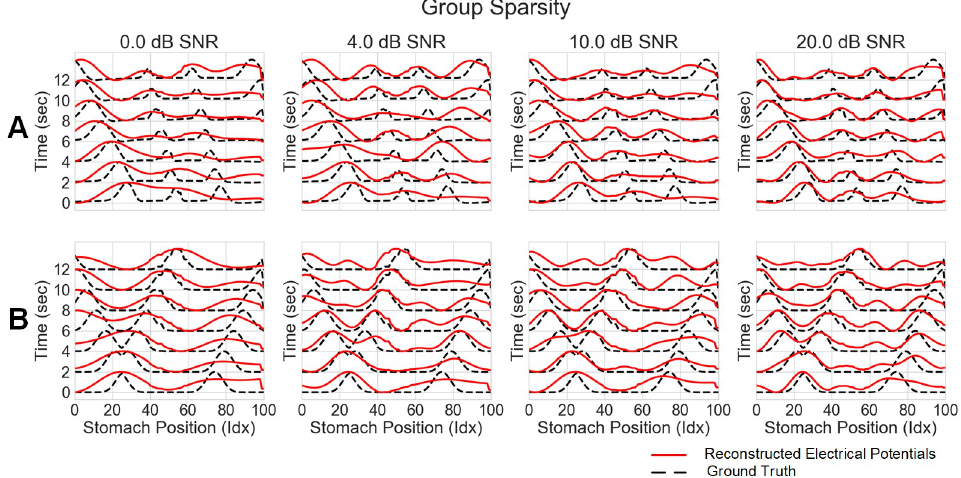
Fig 5. Group sparsity inverse solution on a stomach surface line across noise levels. A) Group sparsity results (electrical potentials) against the ground truth for normal initiation simulation. B) Group sparsity results (electrical potentials) against the ground truth for abnormal initiation. In both normal and abnormal simulations group sparsity is able to reconstruct the ground truth wave pattern even under unrealistically noisy conditions. Additionally the time at which it reconstructs the separate waves in the abnormal simulation is earlier (i.e. the waves are closer together) than in any of the other inverse